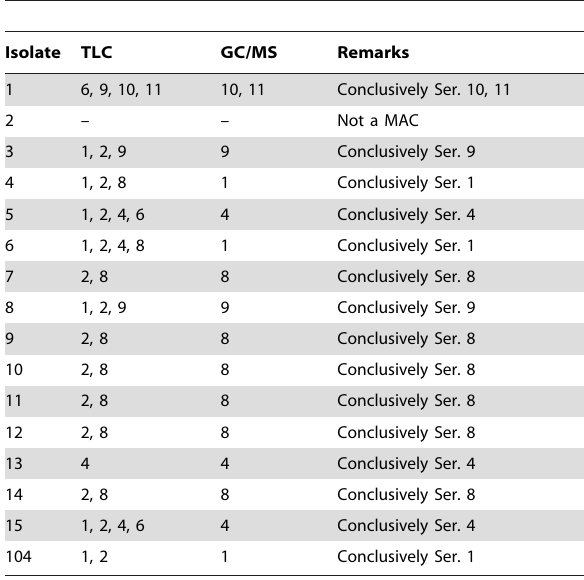
Table 3. Confirmed serovar designation of MAC isolates according to TLC and GC/MS.